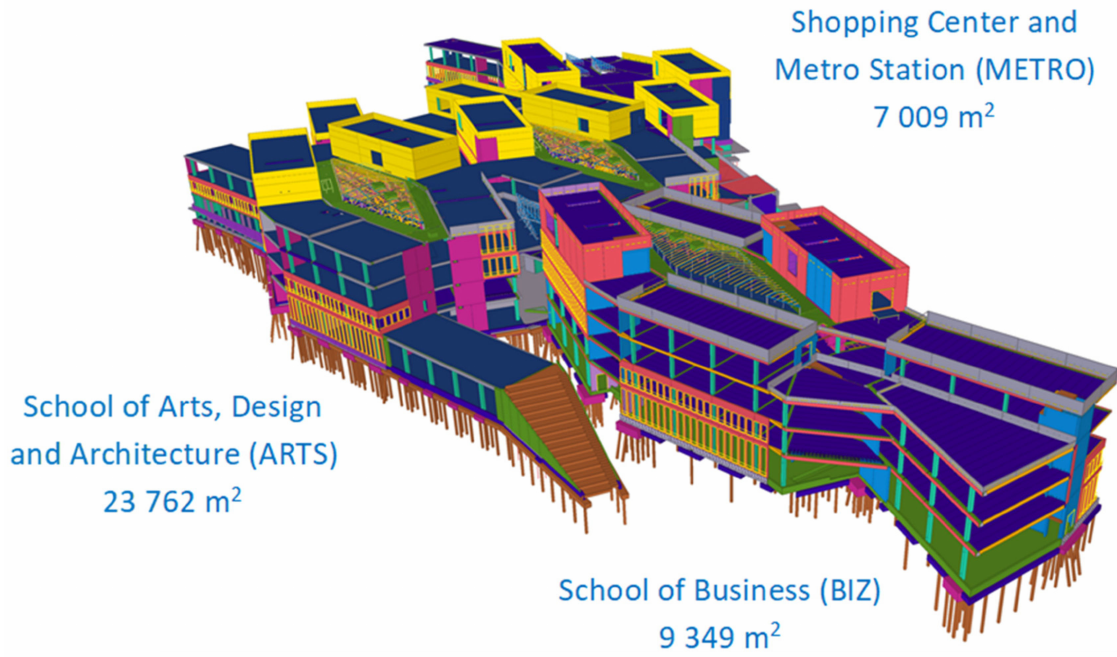
Figure 2. General schematics of Aalto New Campus Complex (image courtesy of Tekla,